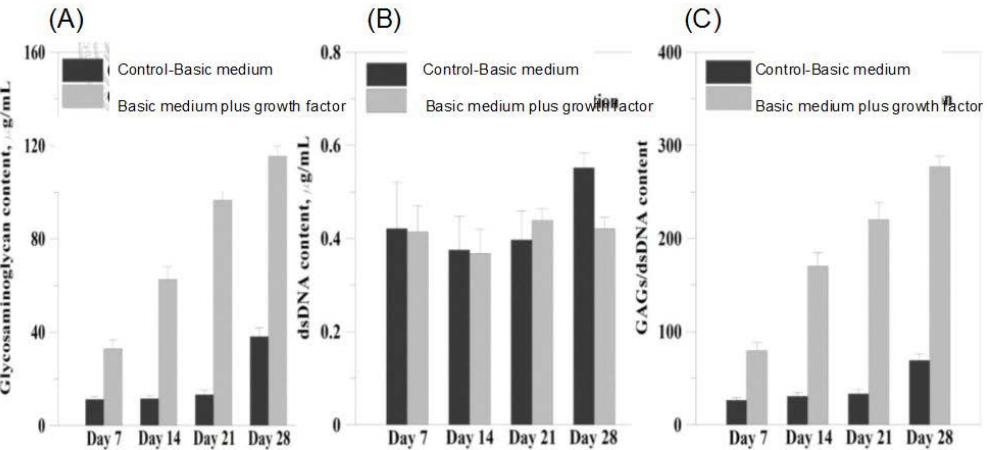
Figure 11. Biochemical analysis of MSCs differentiation. ( A ) sGAG contents of the MSCs after 7, 14, 21, and 28 days of differentiation; ( B ) DNA contents of the MSCs after 7, 14, 21, and 28 days of differentiation and ( C ) normalized s-GAG contents with respect to DNA contents.